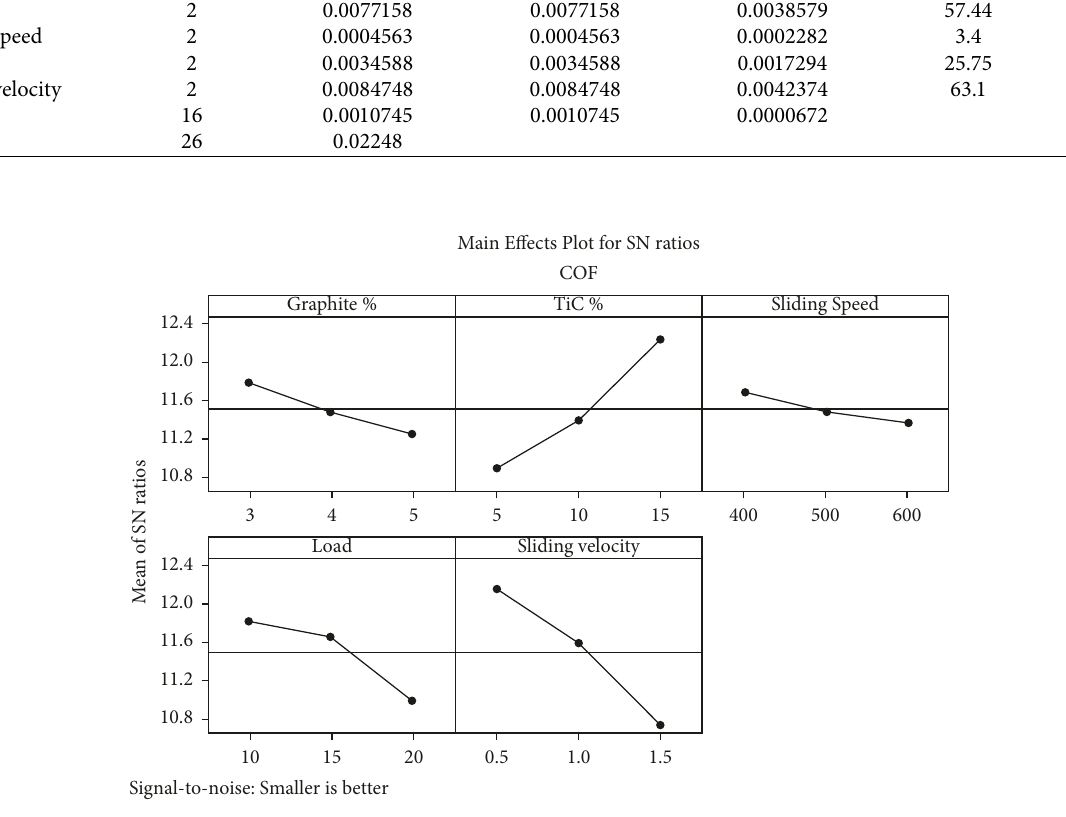
Figure 3: S/N ratio for coefficient of friction.